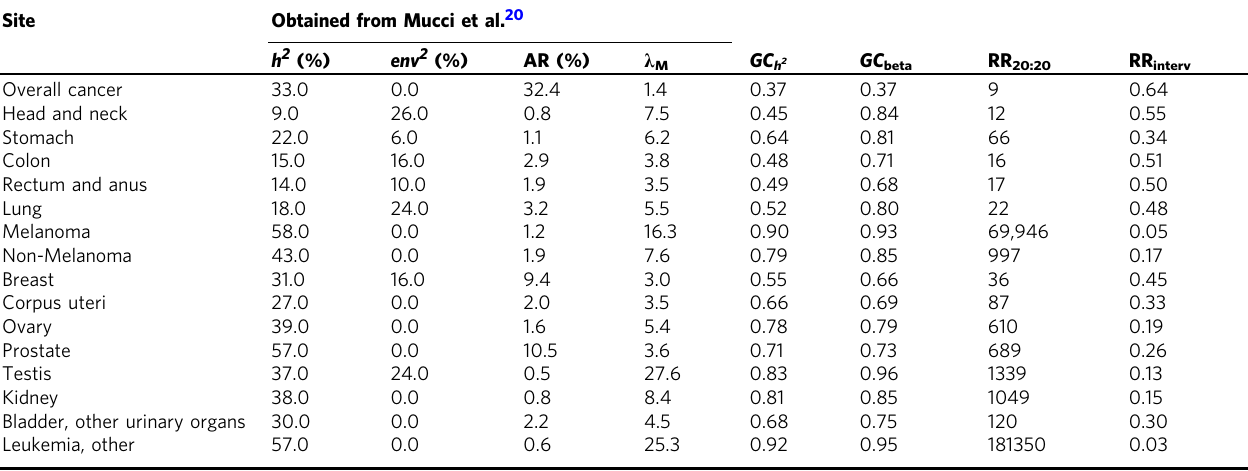
Table 1 Summary measures of the genetic risk of 15 common cancers